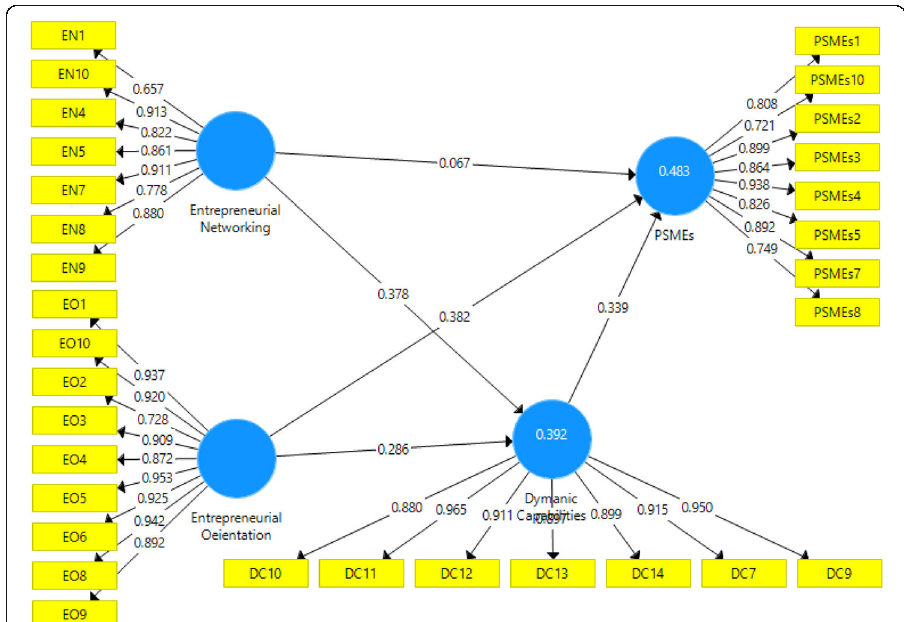
Fig. 3 PLS algorithm ’ s mediation